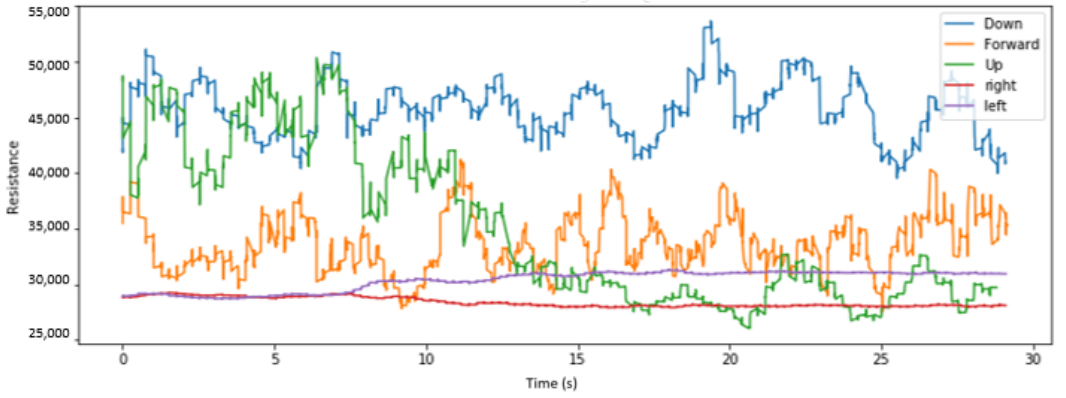
Figure 8. With low placement of short sensor, head tilt filtered data, with right and left tilts added.